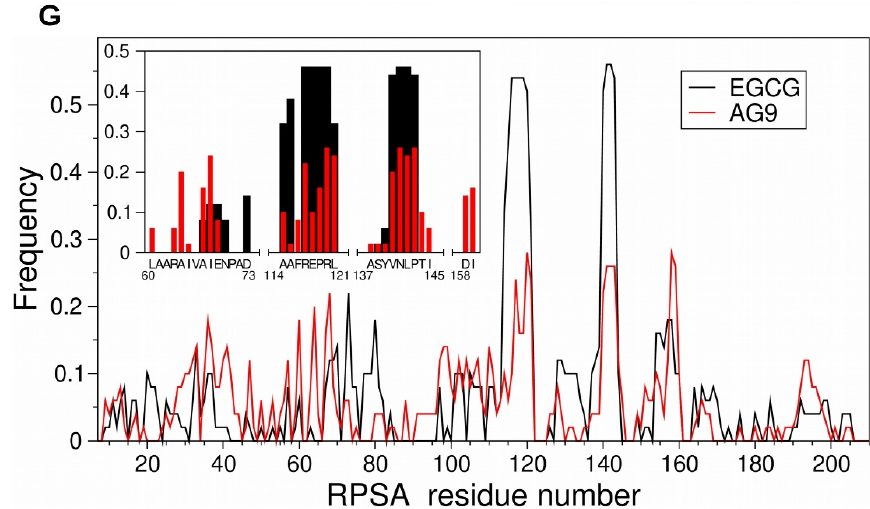
Figure 4. Docking experiments of green tea-derived polyphenol EGCG and AG-9 peptide onto RPSA were performed using Autodock software and evidenced the existence of 4 preferred area of interaction (PAI) for EGCG ( A ) and 3 PAI for AG-9 ( B ). The color code used for the representation of PAI is linked to their population: the most populated one is represented in pink, the second in green, the third in brown, and the fourth in blue. Comparison of the 50 best results of EGCG and AG-9 docking experiments displays an overlapping area (pink PAI). Frequence distribution diagrams of the free energy of binding of the 50 best poses of EGCG onto RPSA demonstrated that those free energies of binding are comprised between − 7.75 and − 4.75 kcal/mol. The most frequent poses have a free energy of binding of − 5.5 kcal/mol ( C ). For AG-9 peptide, the free energy of binding of the 50 best results of docking onto RPSA is comprised between − 2.75 and +1.75 kcal/mol and the energy of binding of the most frequent position of AG-9 onto RPSA is around 0.75 kcal/mol ( D ). The best docking poses of EGCG ( E ) and AG-9 ( F ) are located on the same area at the surface of RPSA. Comparison of the frequency of contacts made by RPSA residues with the 50 best results of EGCG (black line) and AG-9 (red line) reveals two favored regions (frequency above the threshold of 0.2) of the protein ( G ). A focus on the poses associated with the first cluster of EGCG and AG-9 (G/close-up) allows the identification of the following hot spots (frequency above the threshold of 0.2 for the two ligands): R 117 , 120 RL 121 , and the sequence 140 VNLP 143 .